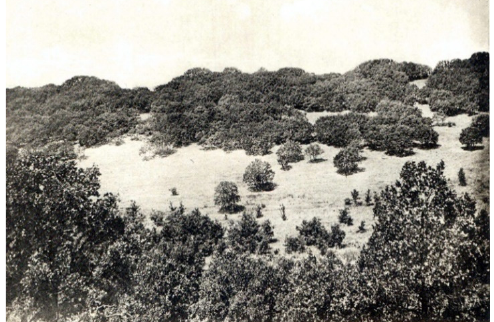
Figure 7. View of Tuluce ş ti Forest (Gârboavele) in 1924 [70].